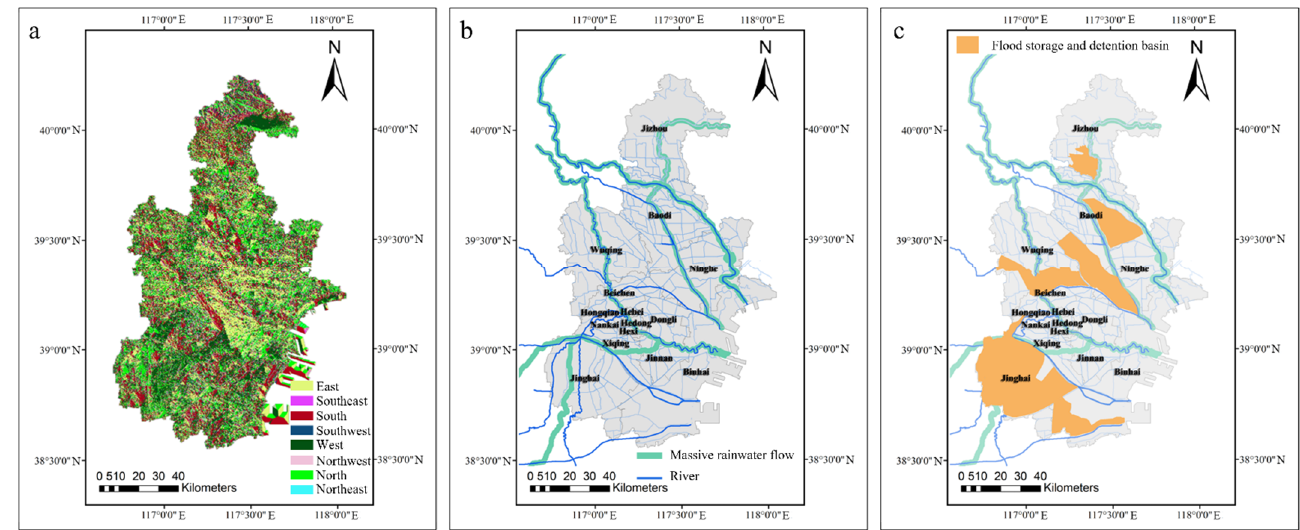
Figure 11. Rainwater flow direction of Tianjin ( a ), flow accumulation of Tianjin ( b ), flood storage and detention basins of Tianjin ( c